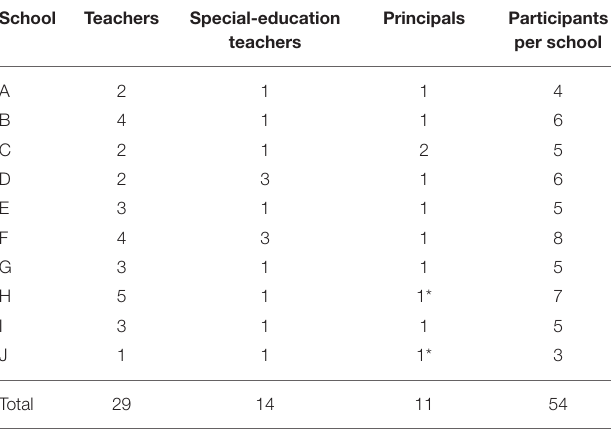
TABLE 2 | Sample of the participants in the